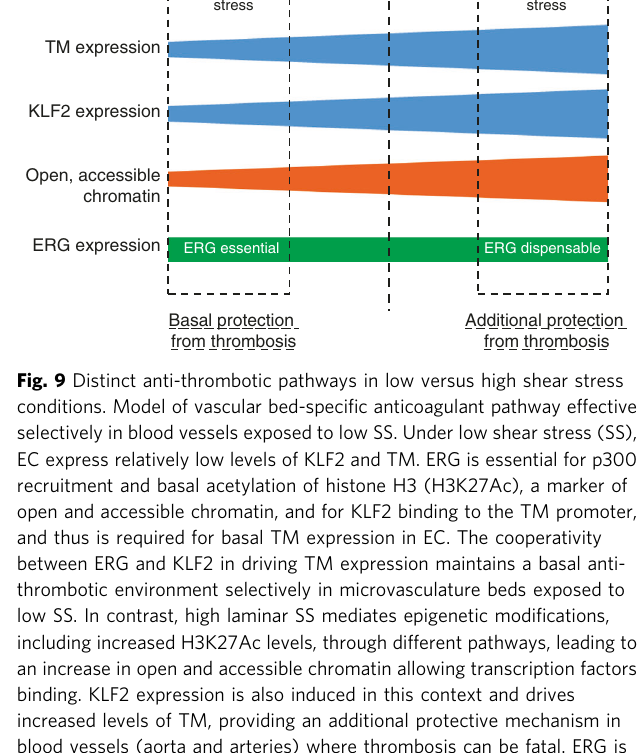
Table 1 Complete list of antibodies used for this study